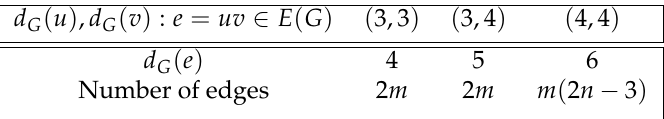
Figure 1. Graph of TUC 4 [ 6, n ] . Table 1. Edge degree partition of TUC 4 [ m , n ]